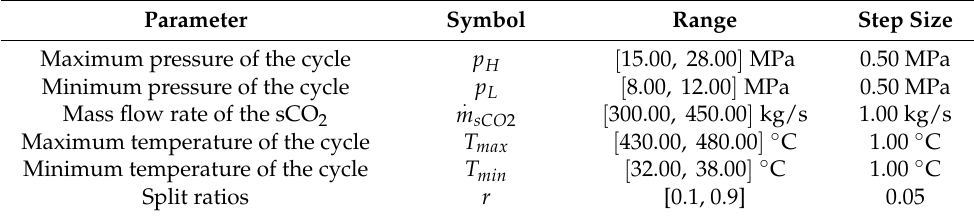
Figure 2. Flow diagram of genetic algorithm method. Table 4. Manipulated parameters in the optimization.